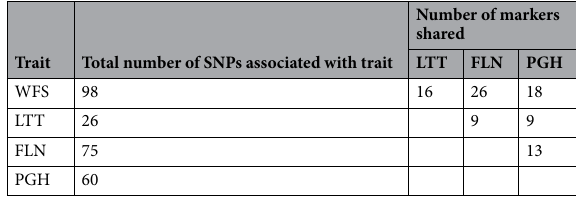
Table 1. Total number and shared SNP markers between traits.